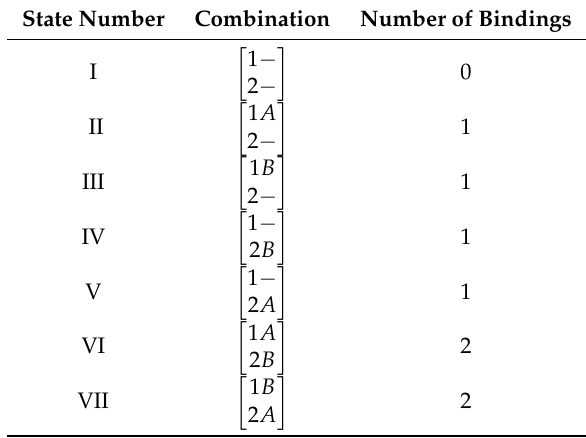
Table 2. Order of the seven possible states for bivalent bindings: as described in Section 2, [ LR 1 ] comprises the sum of the conformational states II, ..., V, and [ LR 2 ] comprises the sum of states VI and VII. State